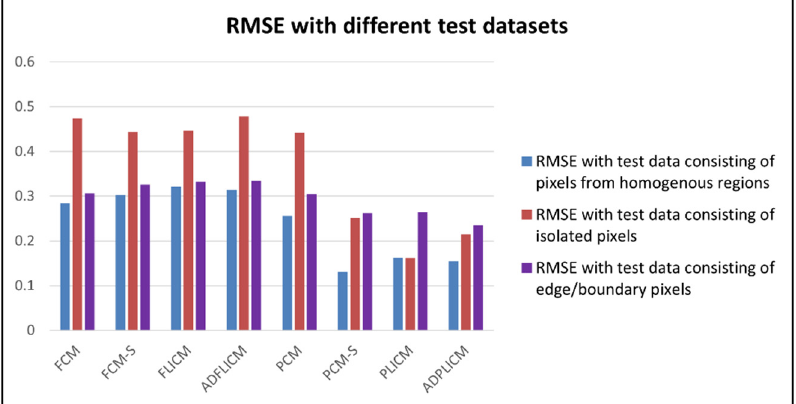
Figure 18. Global RMSE values of classifiers for different test datasets.